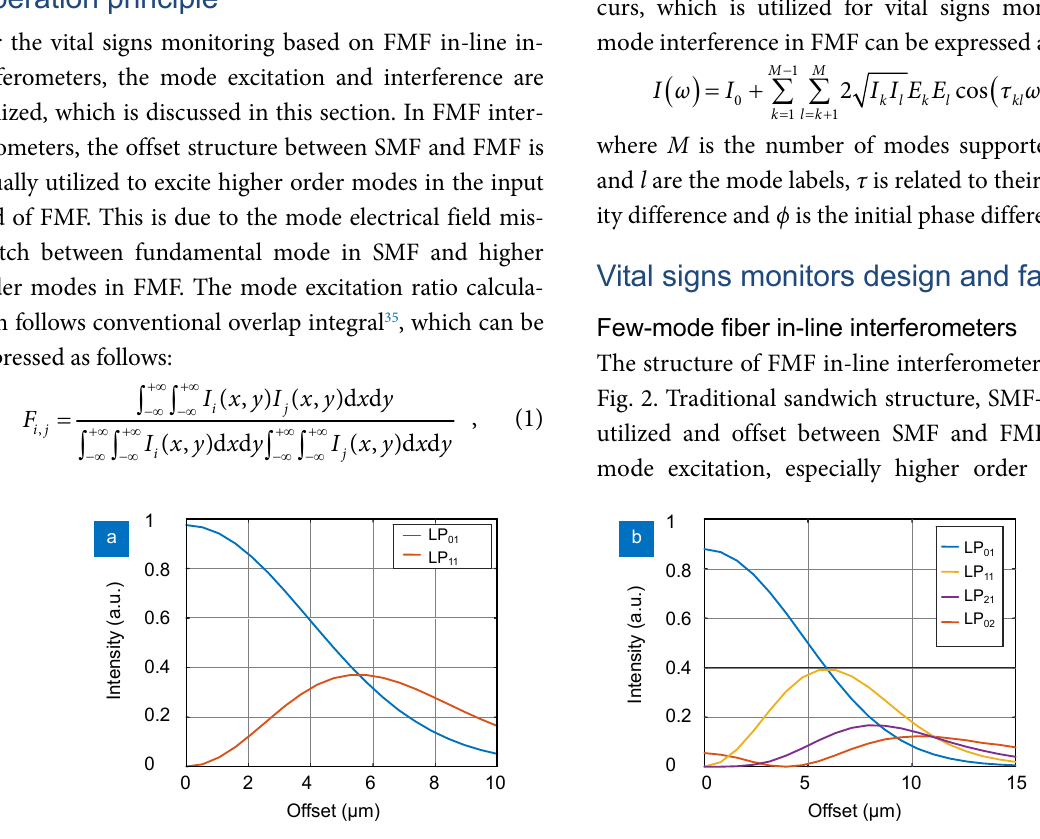
Fig. 1 | The simulated intensity of excited LP 01 mode and LP 11 mode with offset distance between SMF and TMF from 0  m to 10  m (a) and the results of LP 01 , LP 11 , LP 02 and LP 21 modes regarding four-mode fiber